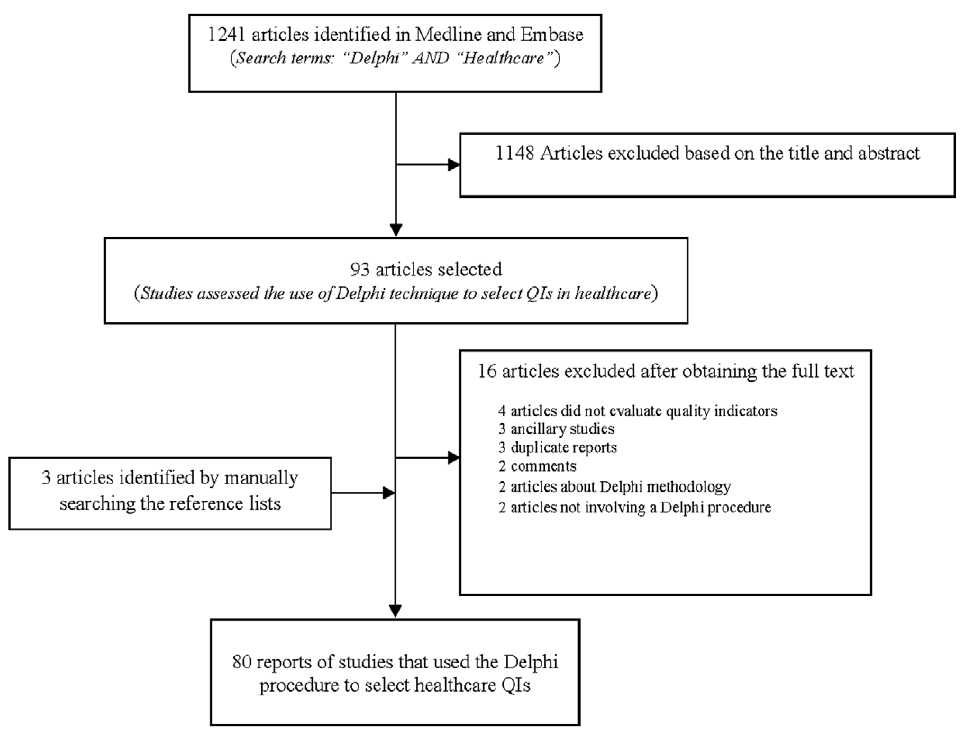
Figure 1. Study selection.